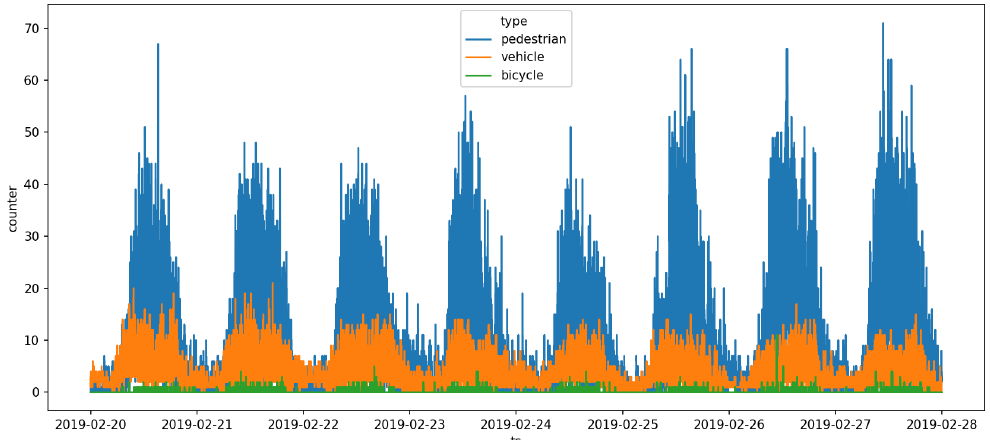
Figure 18. Number of pedestrian, vehicle and bicycle detected by the sensor between 20 February 2019 and 27 February 2019. Each data point represents the number of objects of a specific type detected over the last